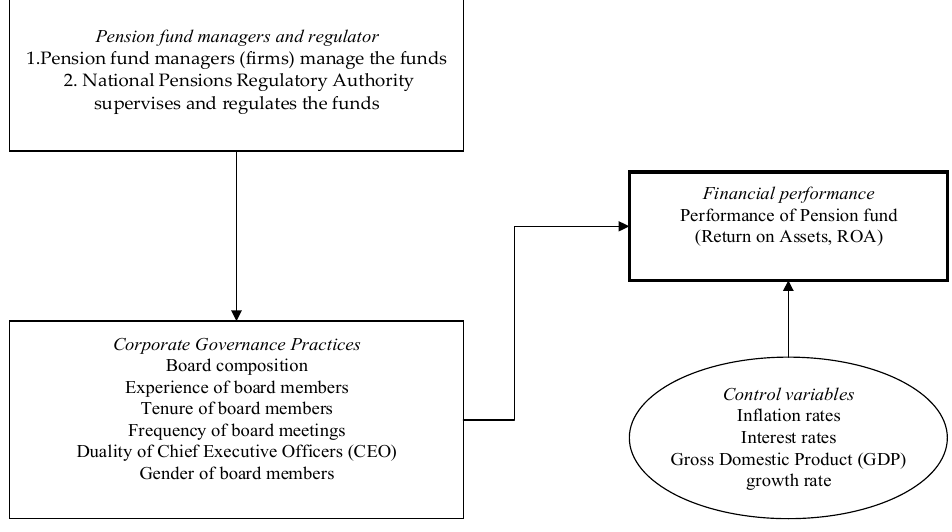
Figure 1. Corporate governance and pension funds.